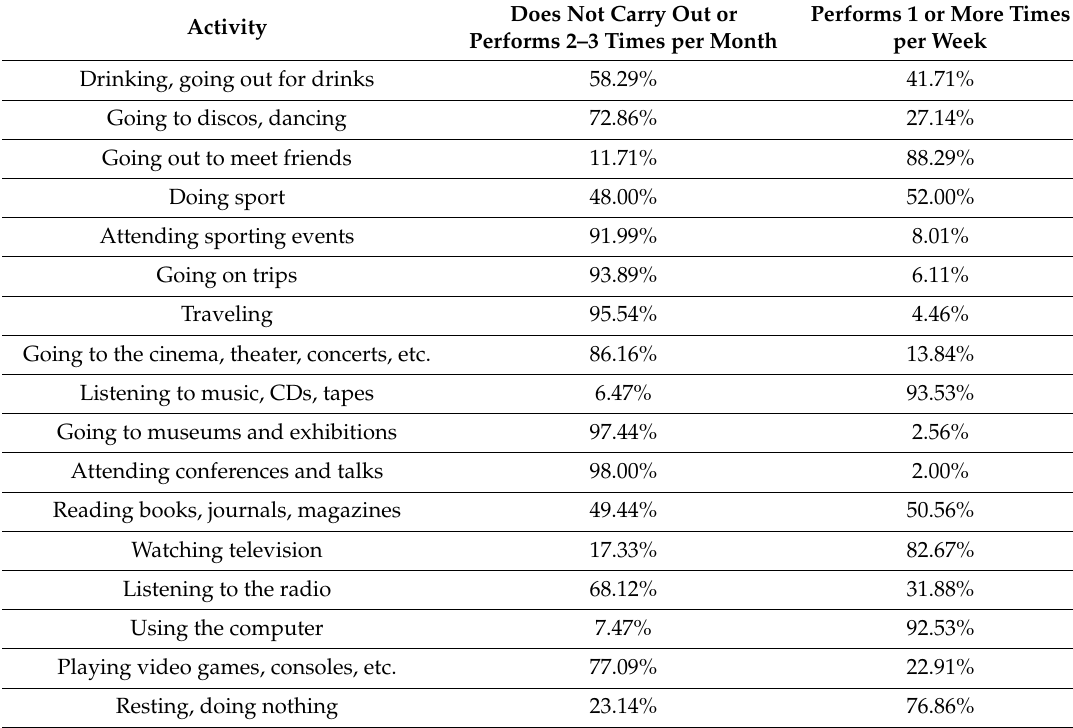
Table 1. Activity performance percentages.